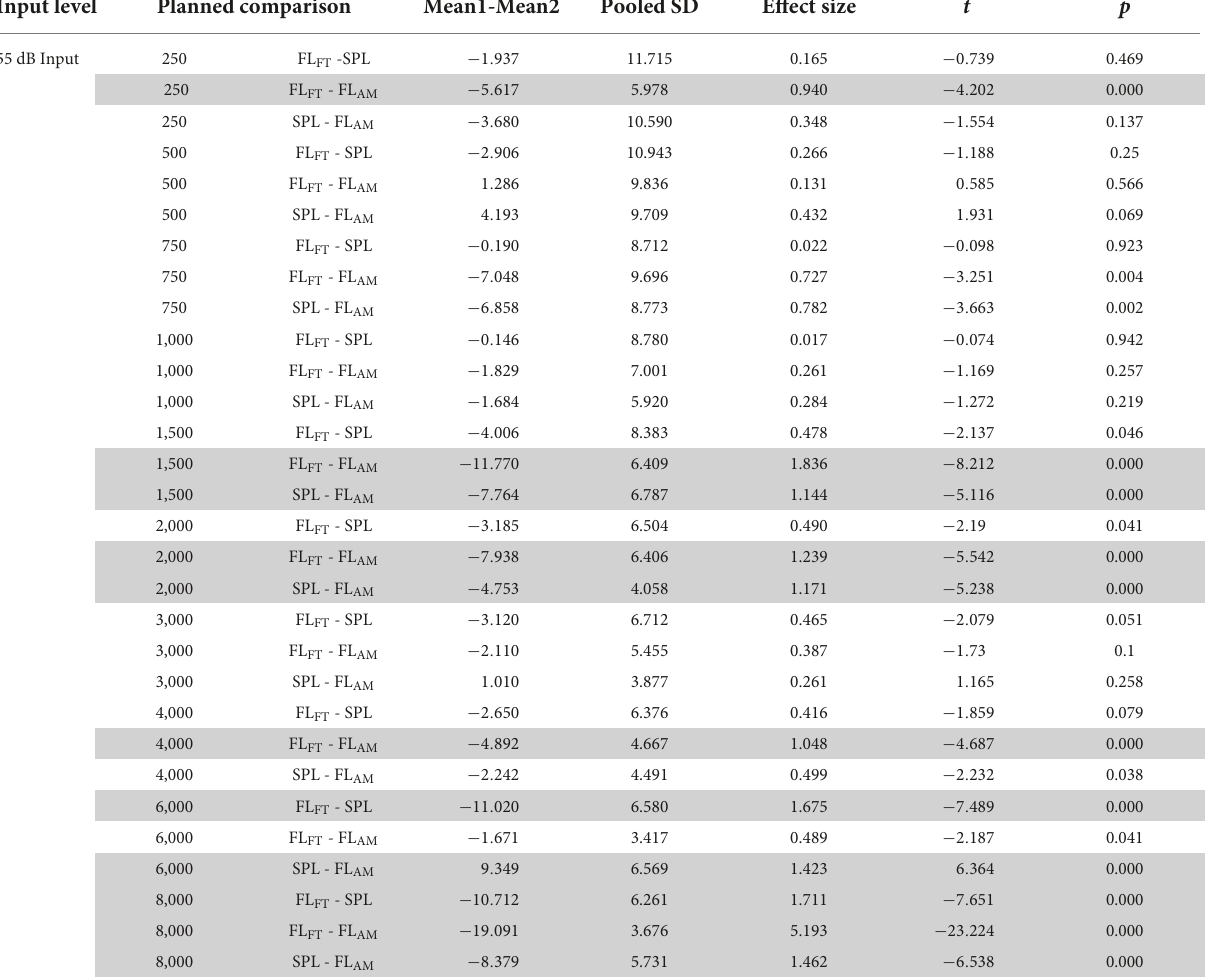
TABLE 1 Results from the t -test showing the p -values when comparing the audibility in 55 dB SPL input for the differences between the three measuring methods (FL FT represents the force transducer method, SPL represents the ear canal method, and FT AM represents the artificial